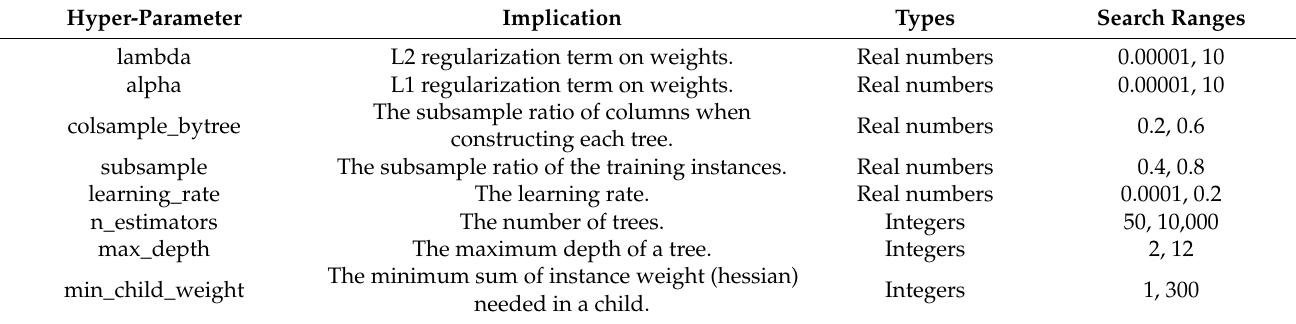
Table 6. The main hyperparameters of the XGBoost model tuned in this study [46,47].